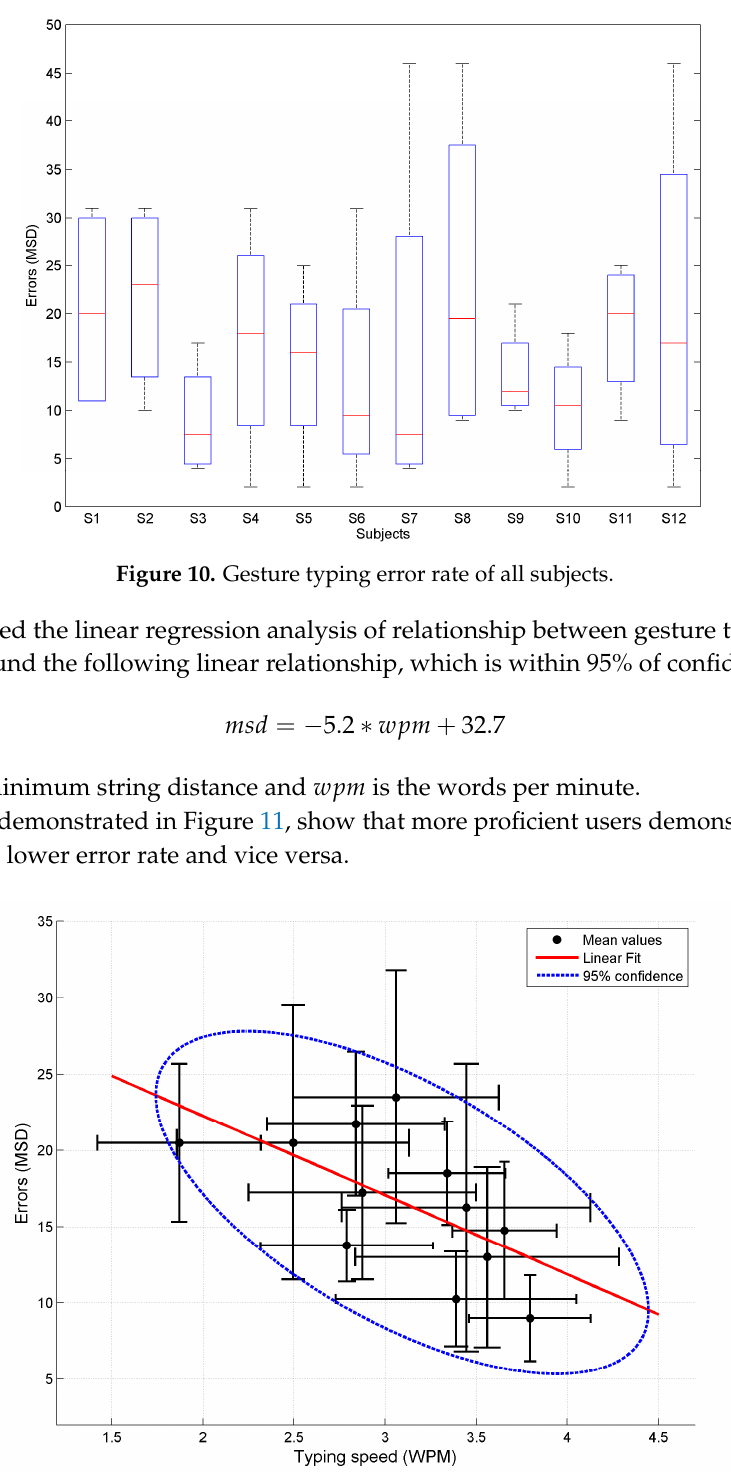
Figure 11. Linear regression analysis of relationship between gesture typing performance and error rate with linear trend and 95% confidence ellipse shown.